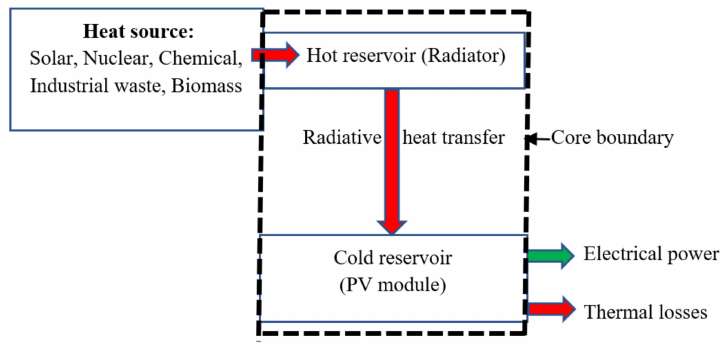
Figure 1. Diagram of the energy conservation of the core of the thermophotovoltaic (TPV)